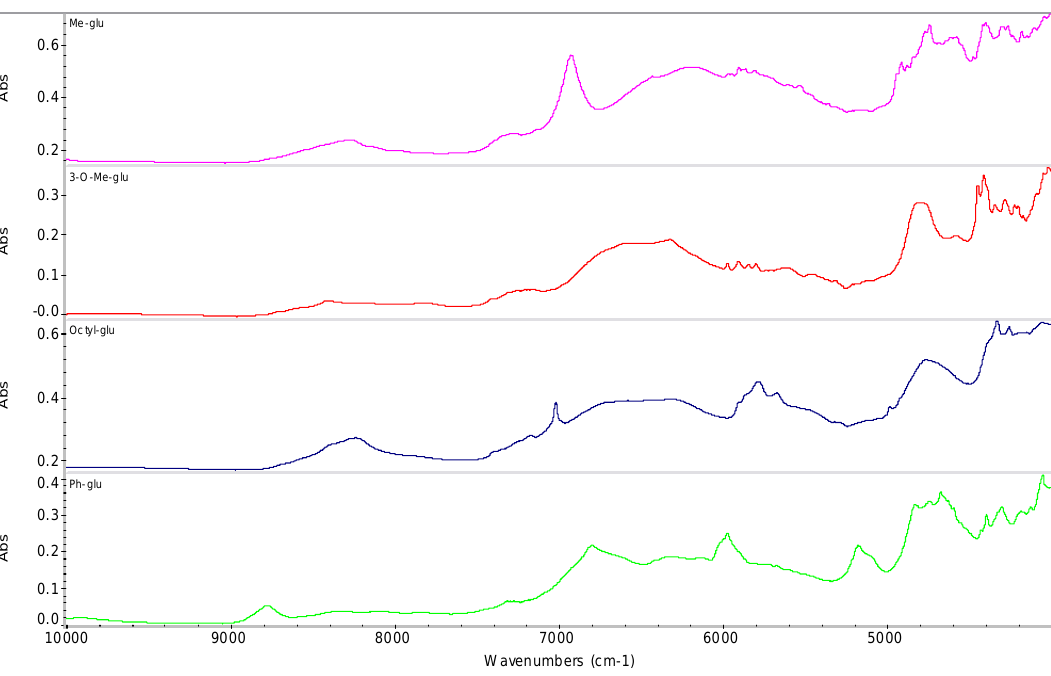
Figure 7. NIR spectra of D -glucopyranose derivatives. (methyl- α - D -glucopyranoside: Me-glu, 3- O -methyl- α - D -glucopyranoside: 3- O -Me-glu, octyl- β - D